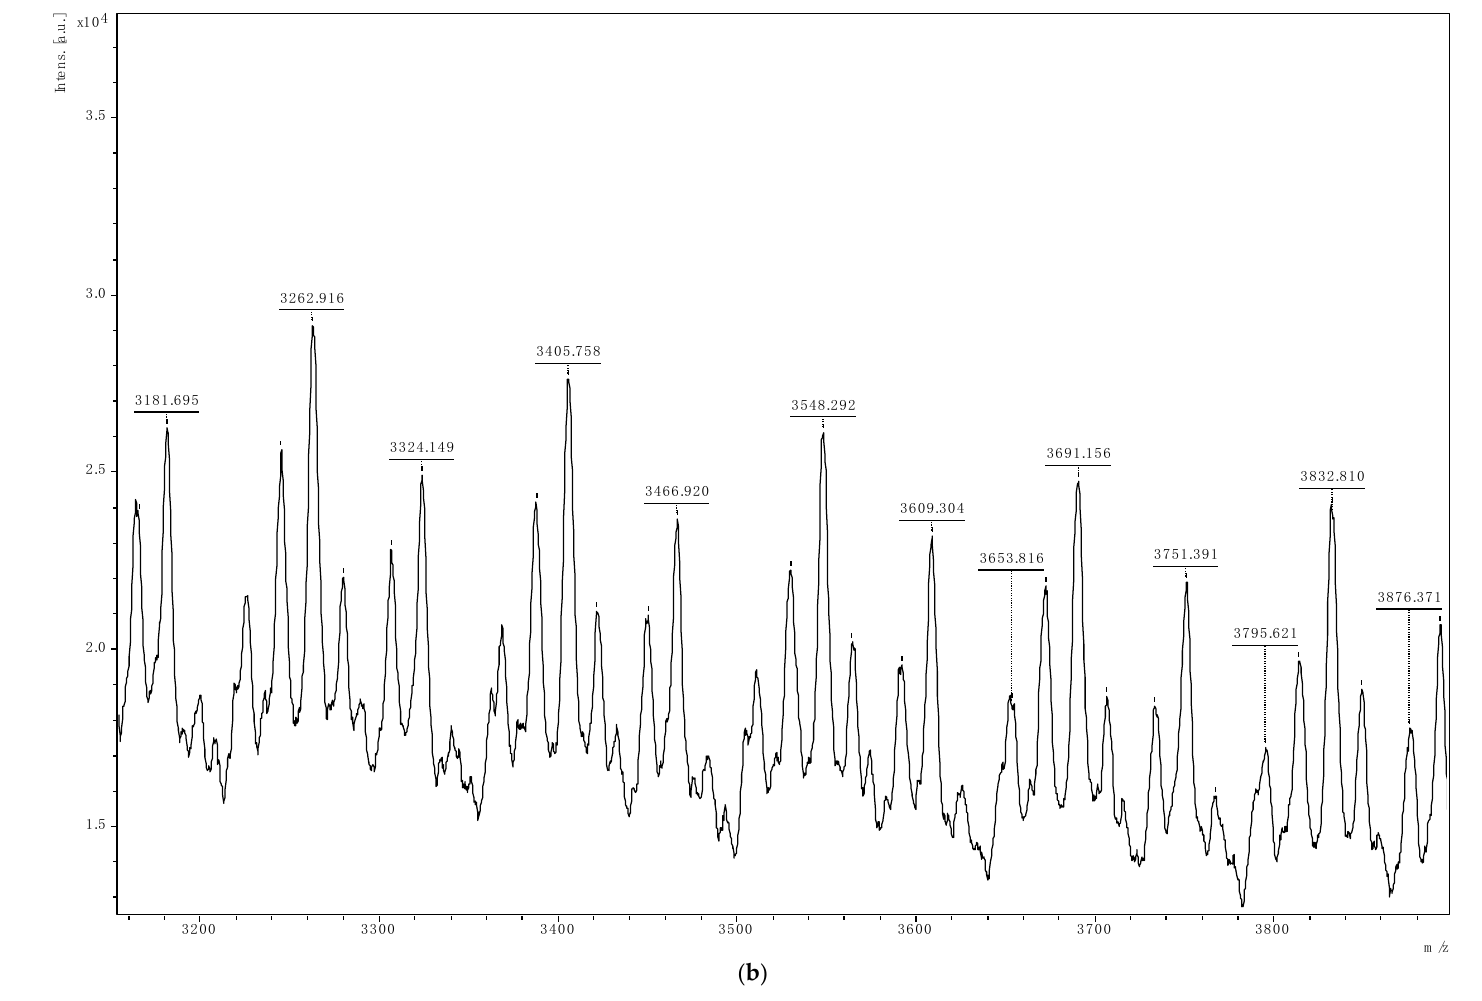
Figure 3. Figure 3a,b are assigned to the mass spectra of the copolymers using complexes 2 and 1 respectively. Figure 3. 3-dimensional (a) and 2-dimensional (b) space of the pressure